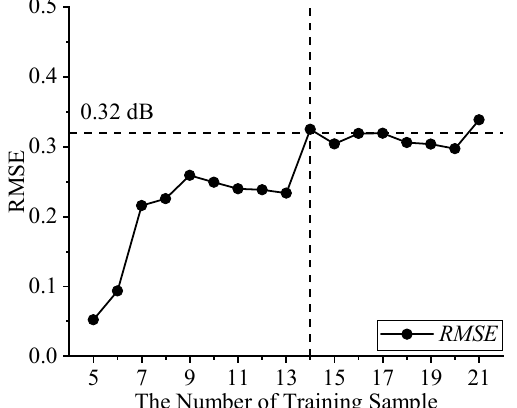
Figure 6. RMSE (dB) between modelled and measured VH backscatters corresponding to di ff erent numbers in the training sample.